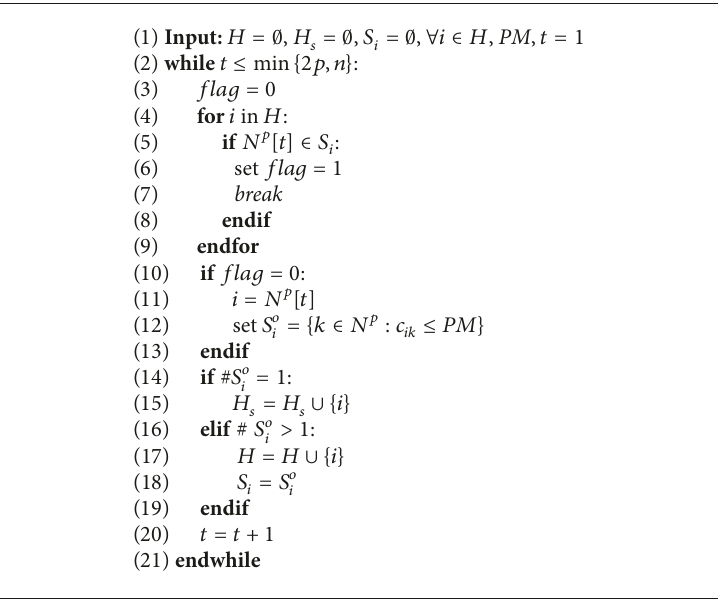
Algorithm 3: Finding the clustering-based potential hub set (CBS).